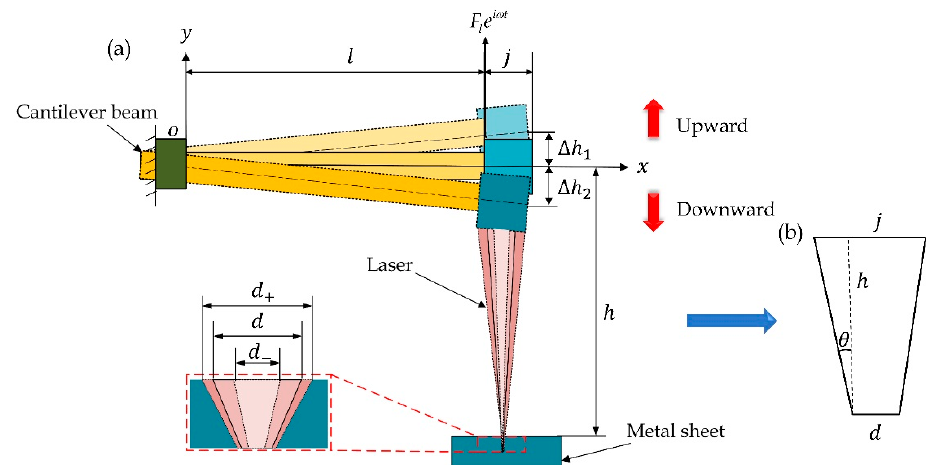
Figure 4. Coordinates of laser machine and vibration model: ( a ) schematic diagram of influence of laser machine vibration on spot size; ( b ) schematic diagram of the relationship between the geometric dimensions, optical path and light spot of the laser processor.